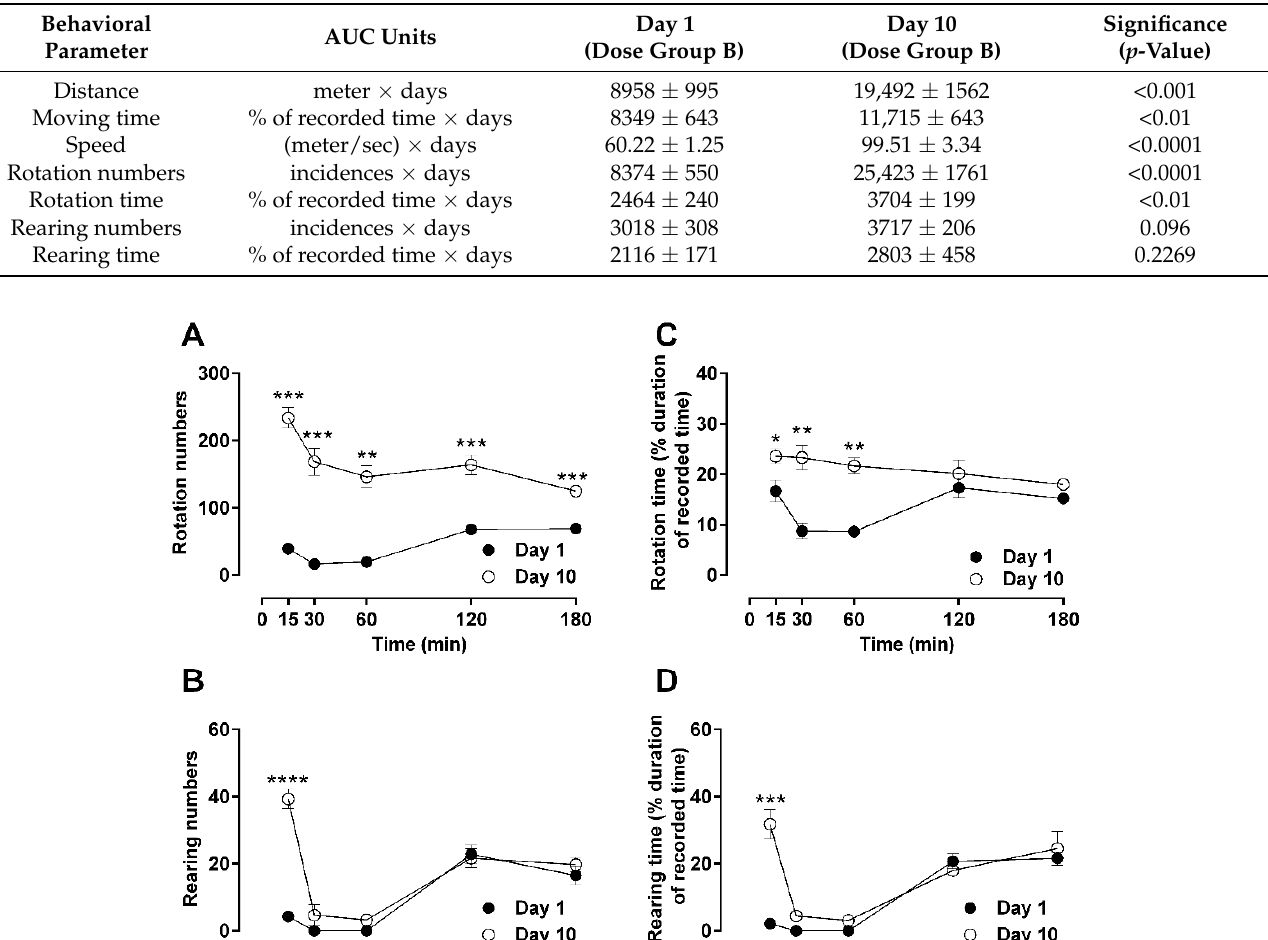
Table 1. Comparison of motor behaviors from day 1 after repeated morphine administration. Total scoring of motor behavior was recorded over 180 min after subcutaneous administration of morphine 10 mg/kg (b.i.d.) over 10 days of repeated treatment. Parameters (presented as the area under curve; AUC) were calculated from the behavioral curves in Figures 1 and 2. Statistically significant differences between AUCs of each behavior were assessed using an unpaired t -test.